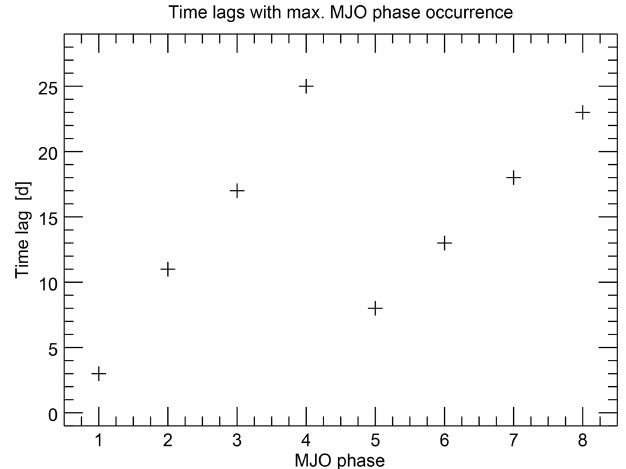
Figure 3. Position of the maximum occurrence numbers (measured in time lag after solar minimum) for each MJO phase. Datasets and filtering conditions are similar to those in Fig.